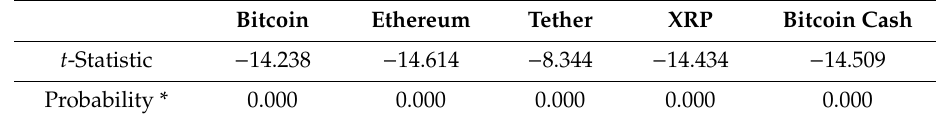
Figure 1. Average daily returns of cryptocurrencies. Table 2. Augmented Dickey-Fuller test to check unit root presence. Table 1. Descriptive statistics.